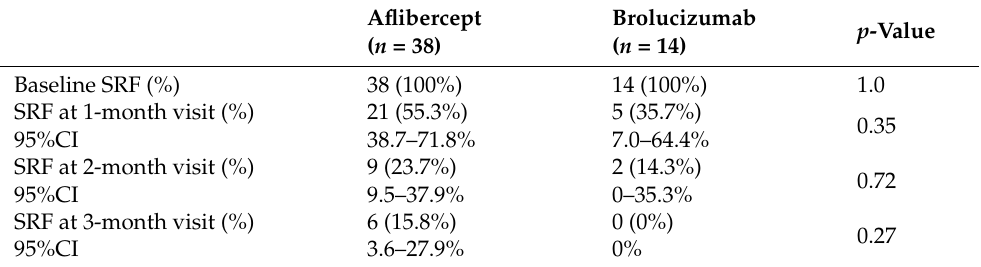
Table 2. Prevalence of subretinal fluid at each visit between two